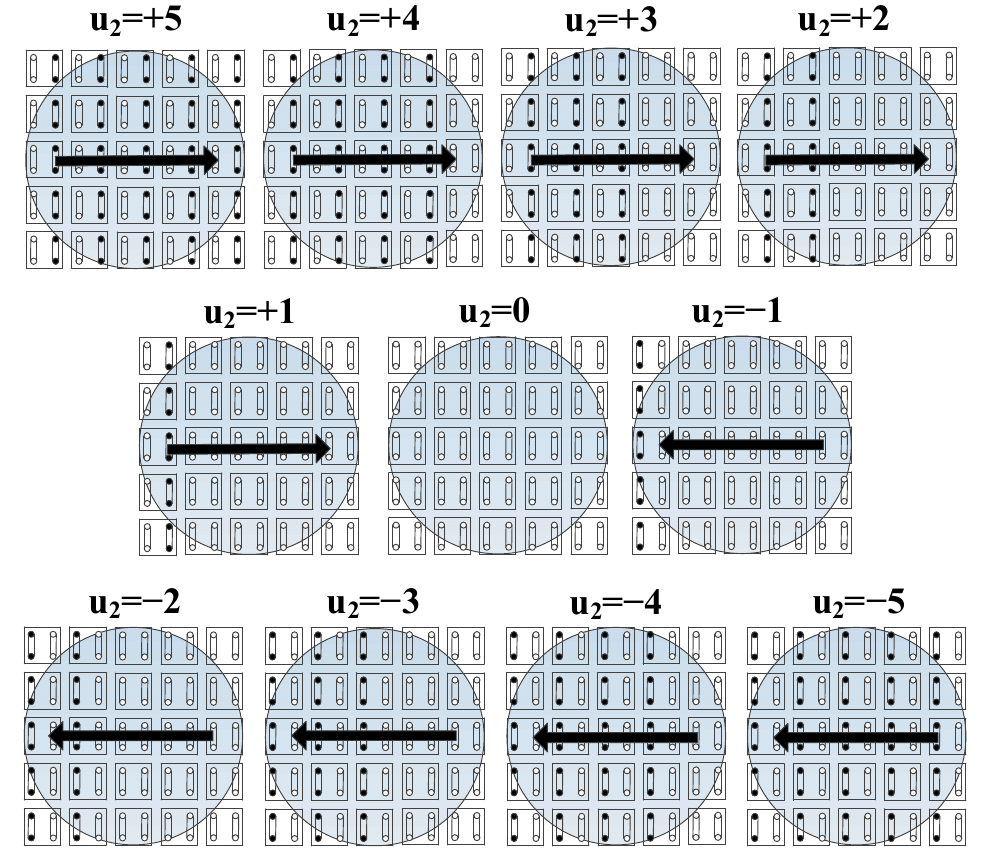
Figure 14. Definition of the control signal for method 2.